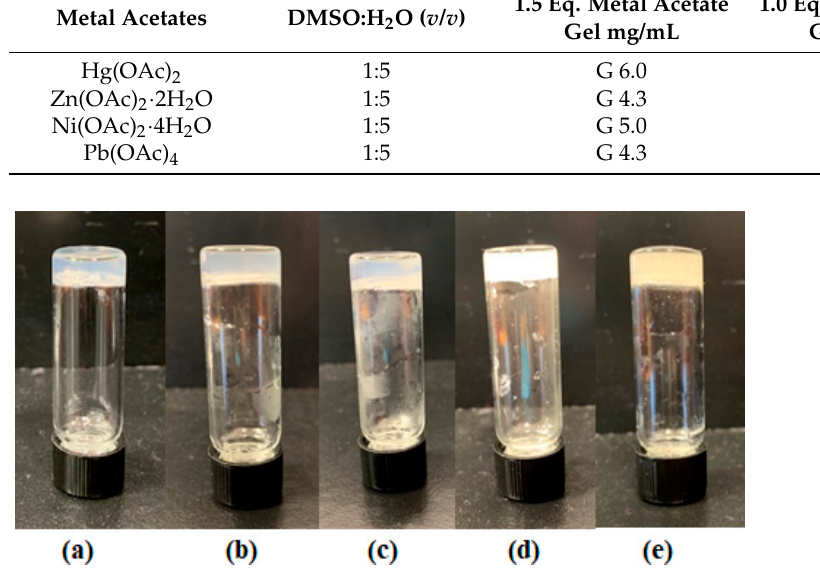
Figure 7. The gels formed by compound 7a and its metallogels with different metal ions in DMSO:H 2 O ( v/v 1:5). ( a ) Compound 7a at 6.0 mg/mL; ( b ) 7a with 1.5 equiv of Ni(OAc) 2 · 4H 2 O at 5.0 mg/mL; ( c ) 7a with 1.5 equiv of Zn(OAc) 2 · 2H 2 O at 4.3 mg/mL; ( d ) 7a with 1.5 equiv of Hg(OAc) 2 at 6.0 mg/mL; ( e ) 7a with 1.5 equiv of Pb(OAc) 4 at 4.3 mg/mL.